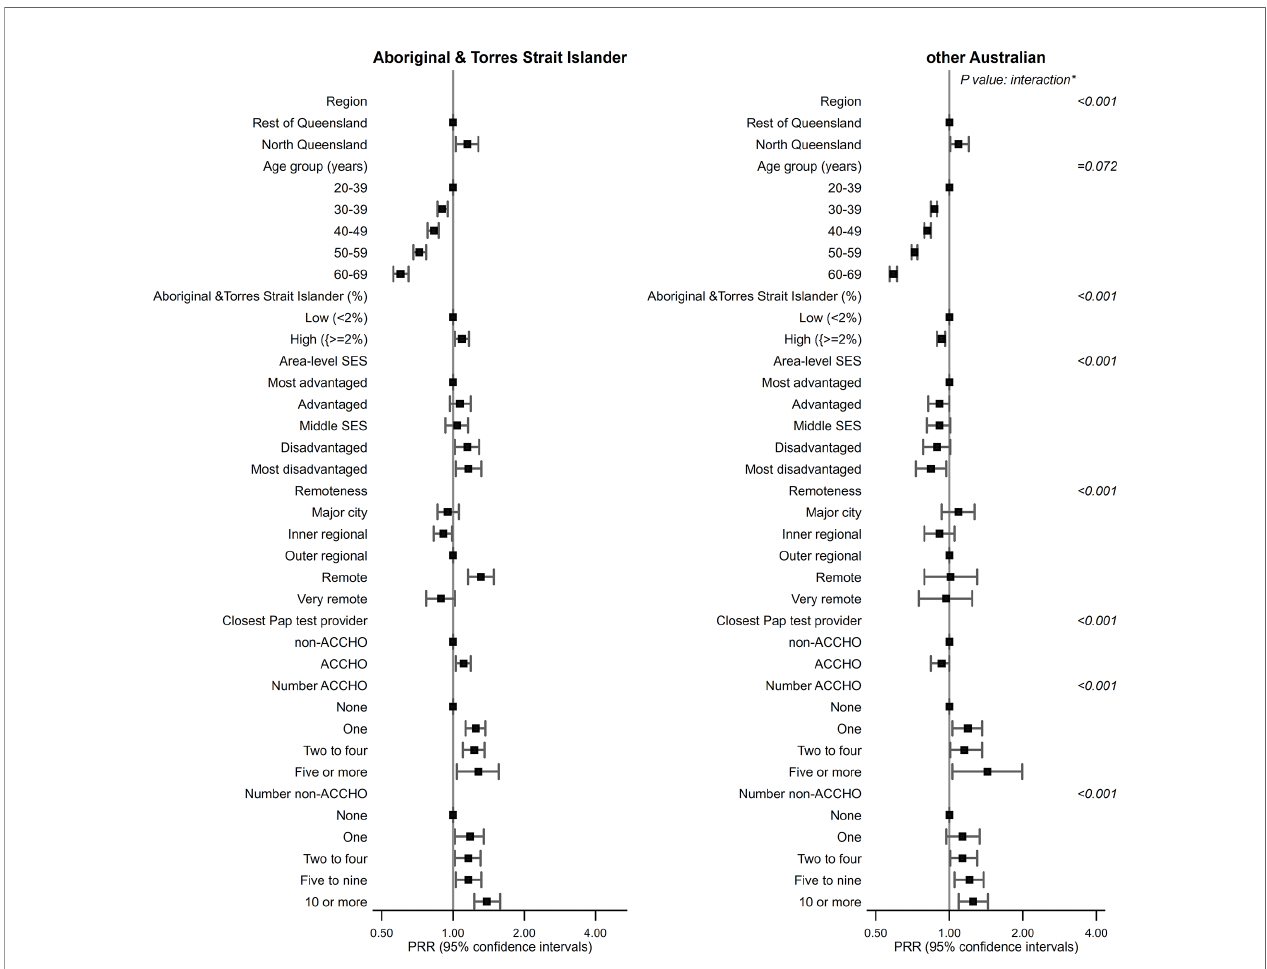
FIGURE 1 | Plot of participation rate ratios (PRRs) with 95% con fi dence intervals for factors associated with screening participation, by region and Aboriginal and Torres Strait Islander status, Queensland (QLD) 2013 – 2017. SES, socio-economic status; ACCHO, Aboriginal Community-Controlled Health Organisation; PRR, Participation Rate Ratios. *interaction term between Aboriginal & Torres Strait Islamder status and each